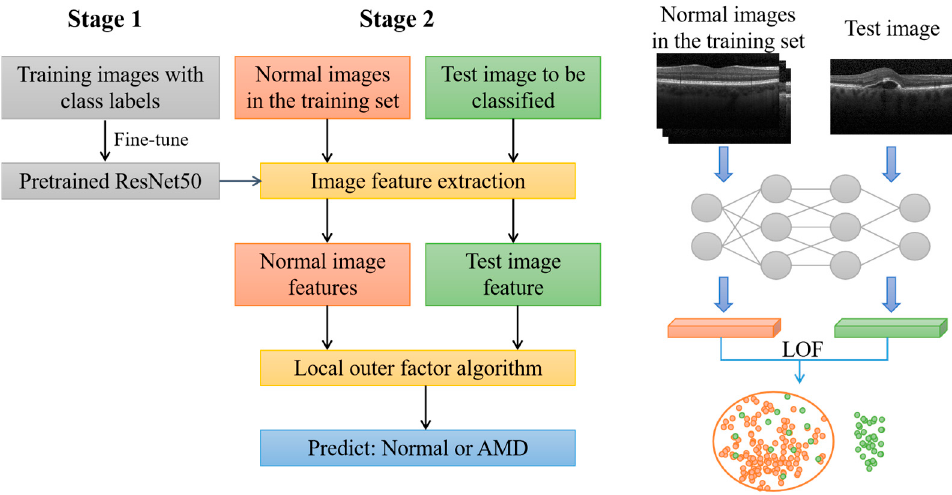
Figure 1. Framework of the proposed approach. Stage 1 is the process of training and Stage 2 is the process of feature extraction and classification. The diagram on the far right is a visual representation of Stage 2.